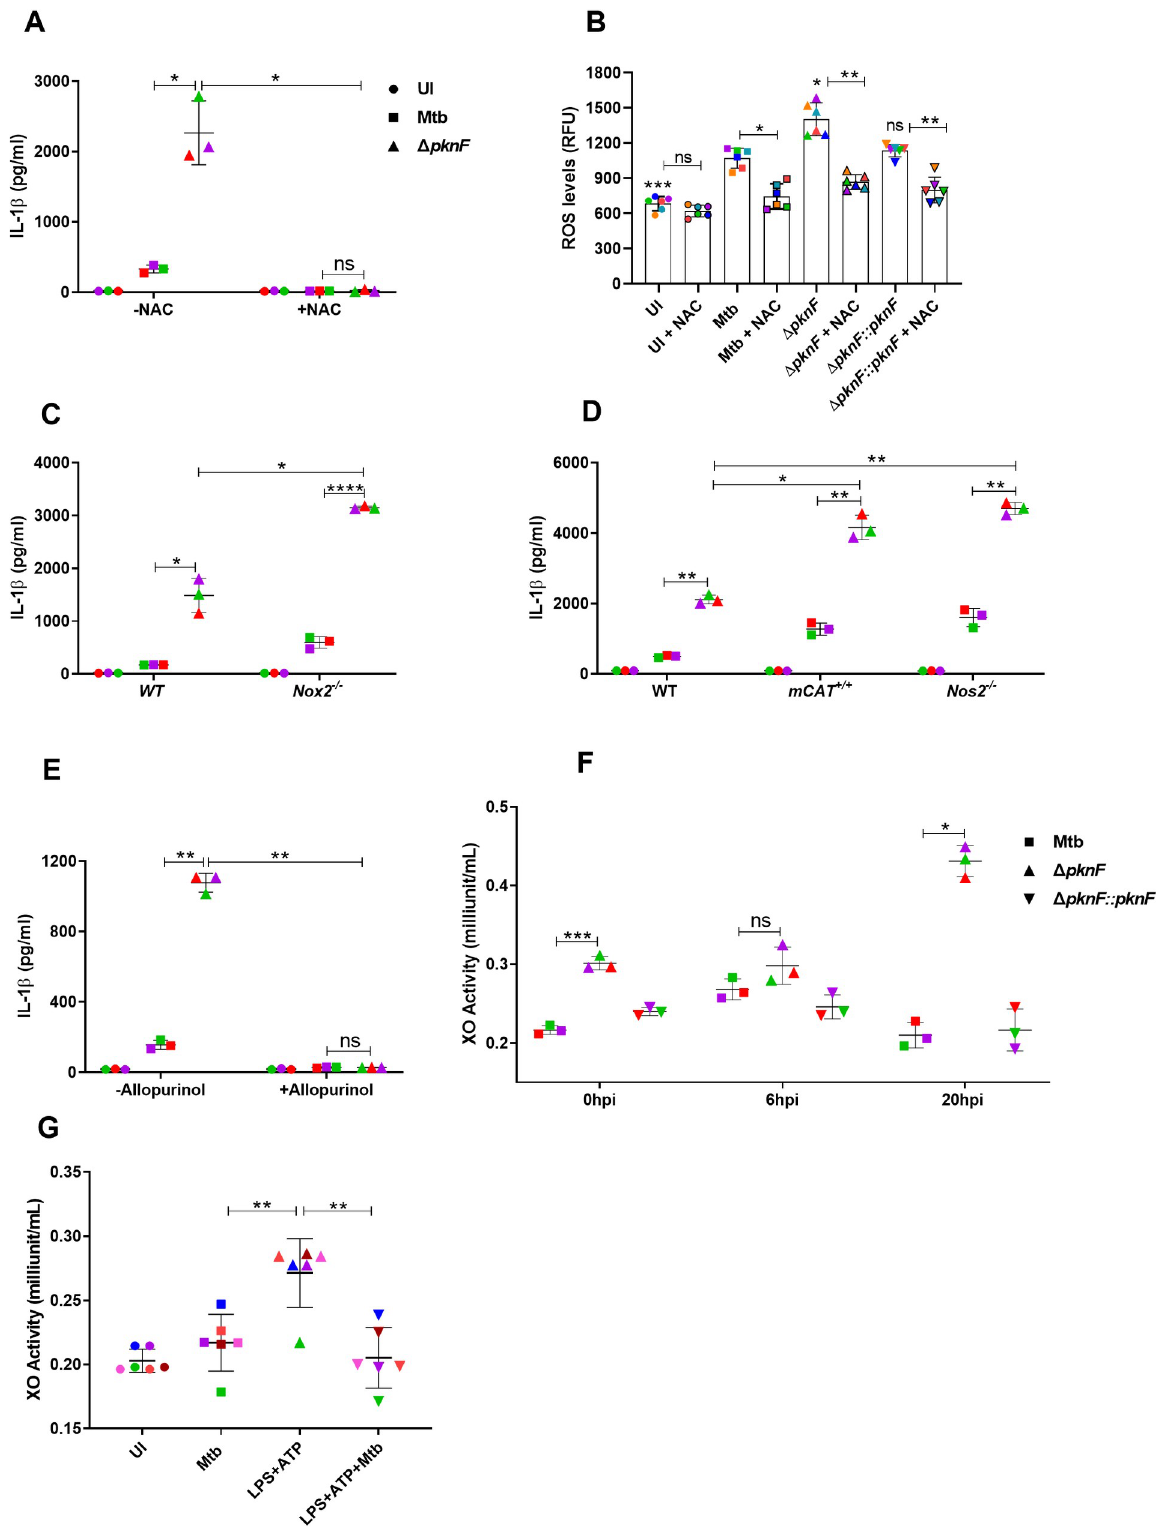
Fig 7. NLRP3 inflammasome activation by pknF Mtb mutant is dependent on xanthine oxidase (XO)-mediated generation of reactive oxygen species (ROS). BMDMs were either left untreated (-NAC) or treated with ROS scavanger, NAC (10mM) and then infected